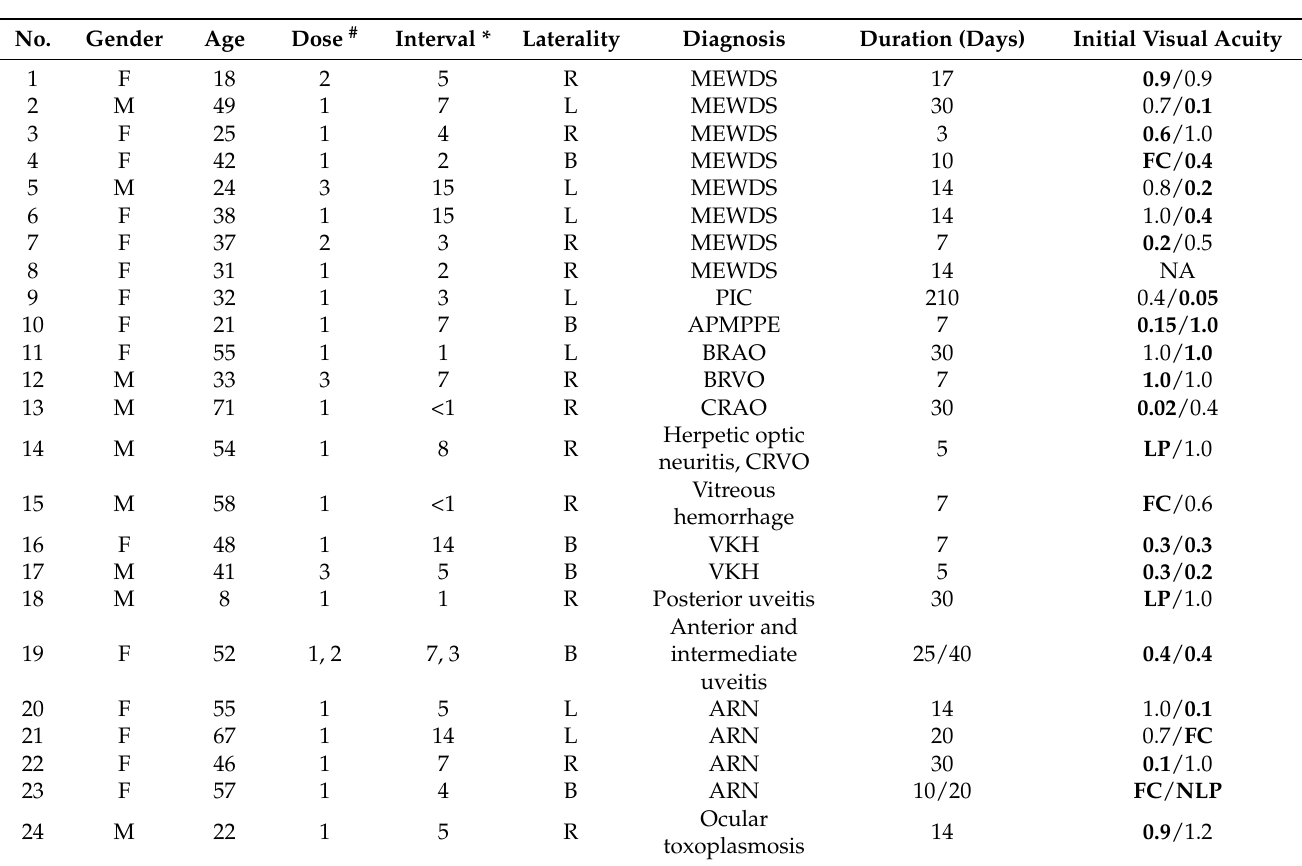
Table 1. Demographic and clinical information of patients with ocular adverse events after vaccination with an inactivated COVID-19